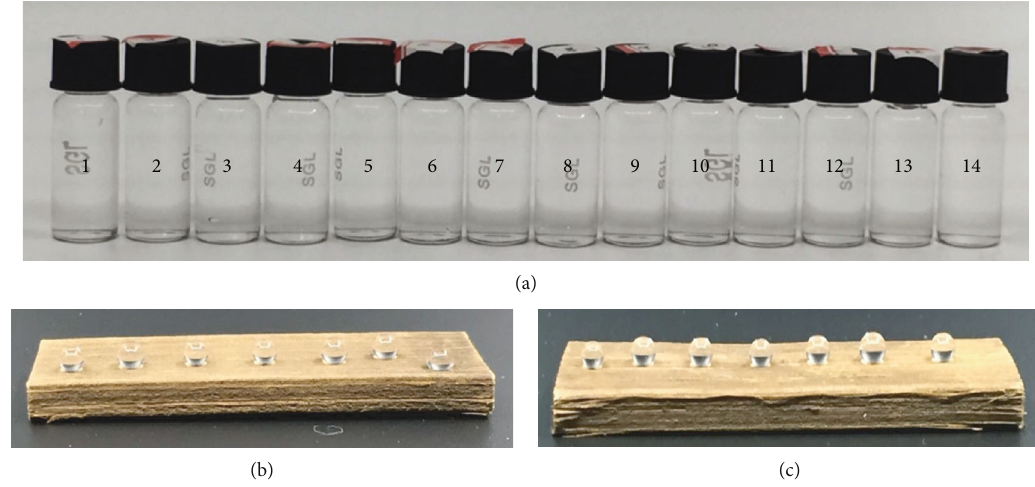
Figure 9: Digital photos of FAS-RGO@SiO